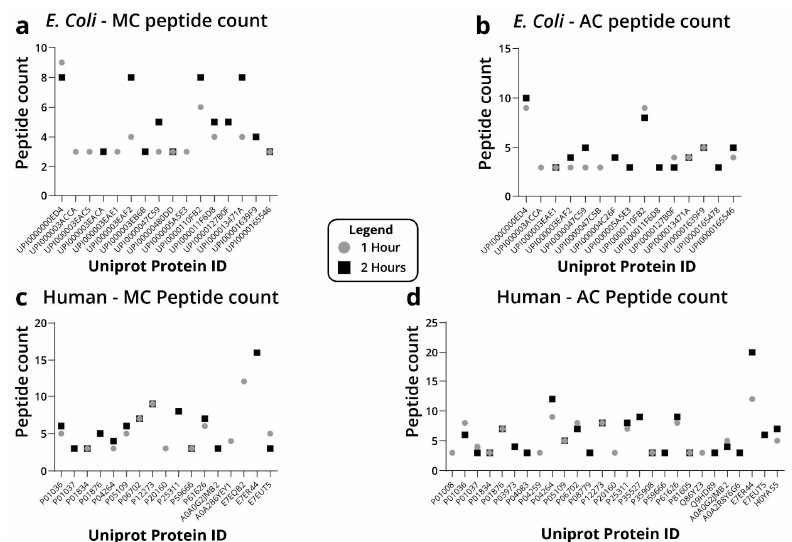
Figure 4. Number of peptides identified for each protein identified by 1 and 2 h MS run and their Uniprot ID. ( a ) Peptide count of E. Coli proteins after methanol ‐ chloroform precipitation. ( b ) Peptide count of E. Coli proteins after acetone precipitation. ( c ) Peptide count of human proteins after methanol ‐ chloroform precipitation. ( d ) Peptide count of human proteins after acetone precipitation. Human proteins are known to be abundant in the saliva and gingival crevicular fluid trapped within the dental calculus [7]. Thus, calibrating their analysis will help to identify proteins of lower abundance. In this regard, a 1 h following methanol ‐ chloroform precip ‐ itation identified 12 proteins, compared to 14 proteins identified in the 2 h run (Figure 3). When comparing proteins identified after acetone precipitation, 23 proteins were identi ‐ fied in the 2 h run compared to 19 in the 1 h run (Figure 3). In agreement with the E. coli data, a 2 h gradient was likely to identify more proteins, at the expense of longer run times.